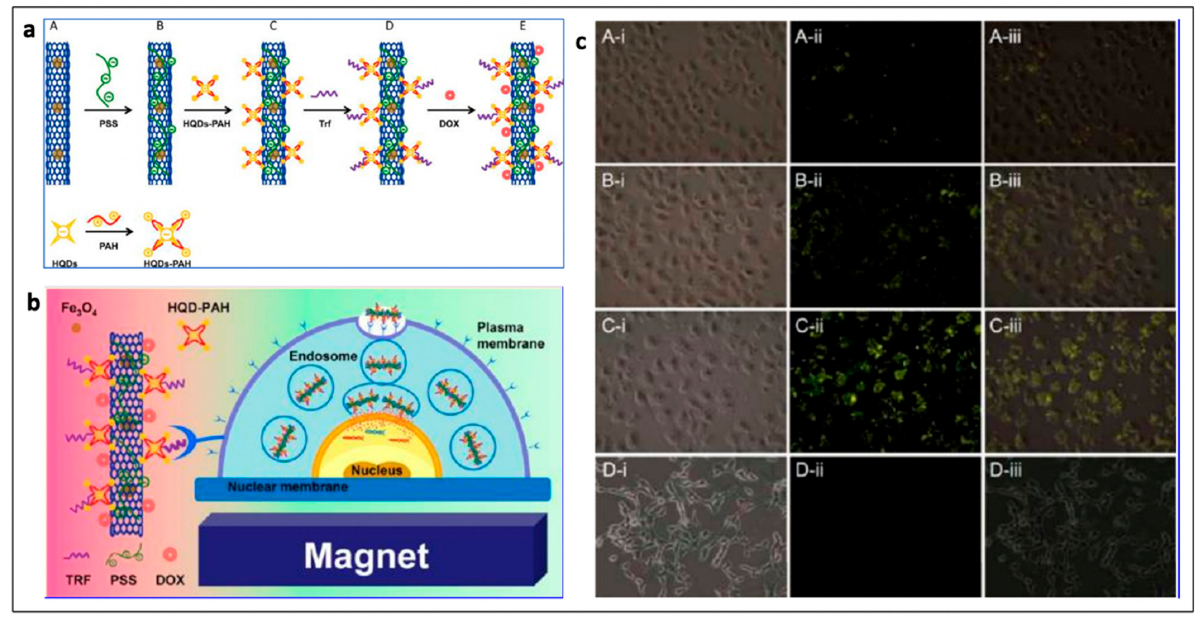
Figure 2. ( a ) Scheme for preparation of DOX-Fe 3 O 4 @CNT-HQDs-Trf Conjugates. (A) Hollow cavity of CNTs filled with Fe 3 O 4 NPs (Fe 3 O 4 @CNT); (B) Coated with poly (sodium 4-styrenesulfonate) (PSS); (C) Exterior decorated with poly(allylamine) (PAH) capped SiO 2 -coated quantum dots (HQDs) to give Fe 3 O 4 @CNT-HQDs; (D) Surface further decorated with transferrin (Trf) to give